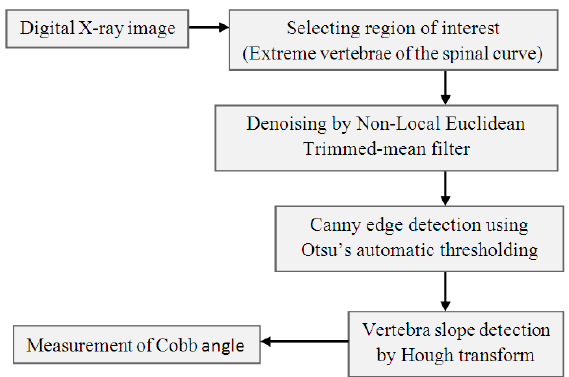
Figure 4. Flow diagram of Cobb angle measurement technique; (Source: Kundu et al.,